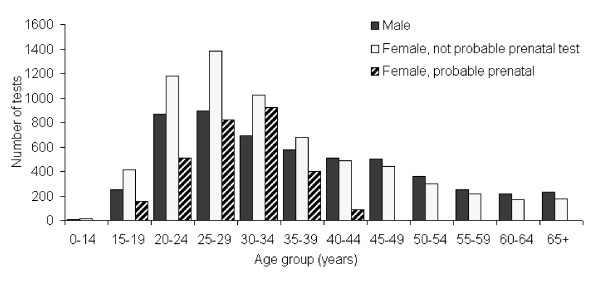
Number of HIV Screening Tests by Sex and Age Group, Females Disaggregated by Probable Prenatal Test, CDHA Laboratory, April 16th 2009 - April 15th 2010.